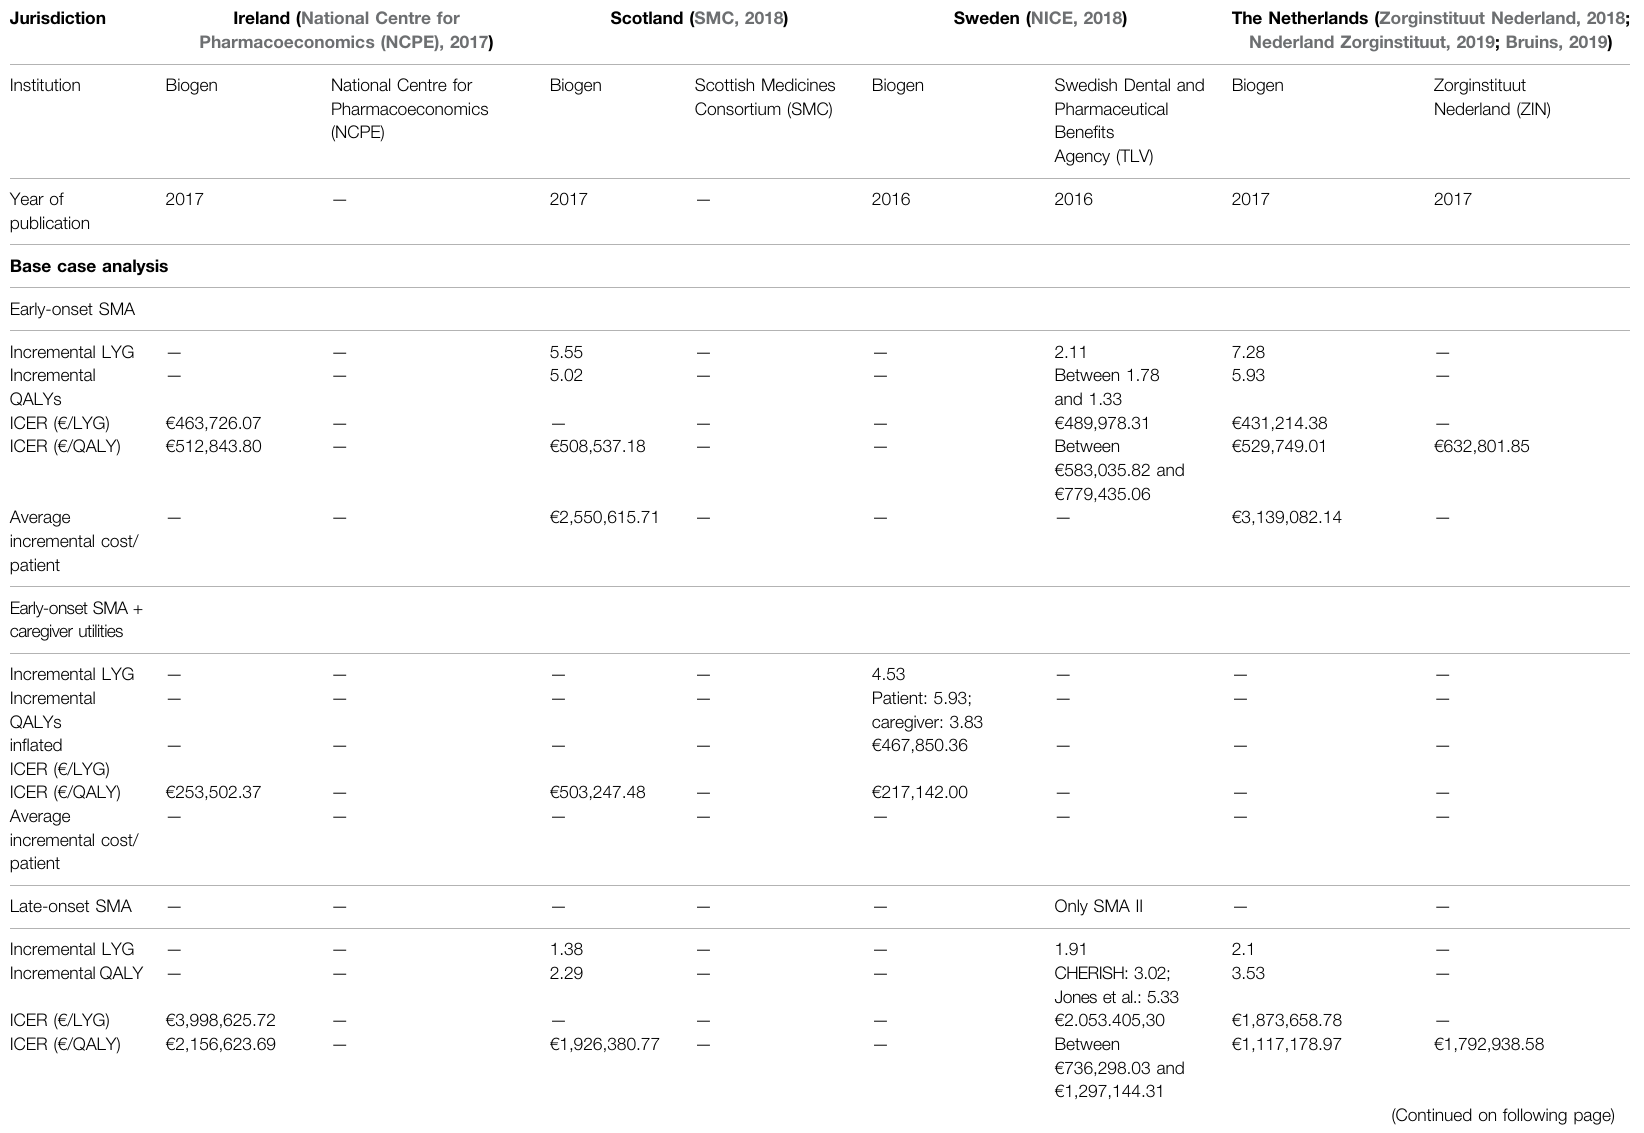
TABLE 3 | Overview of the results of the economic evaluation of nusinersen in six European countries, the US, and Canada a